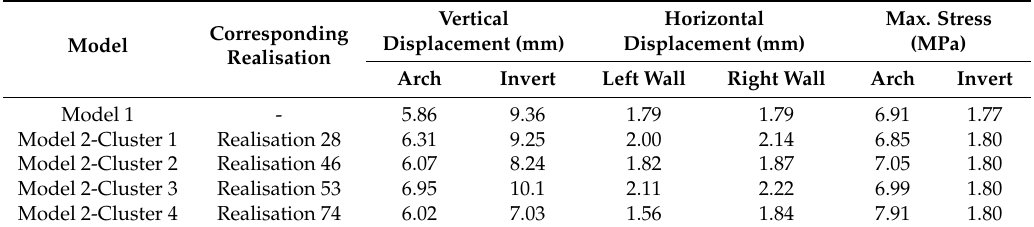
Table 6. Summary of the displacements and stresses results obtained in models 1 and 2.